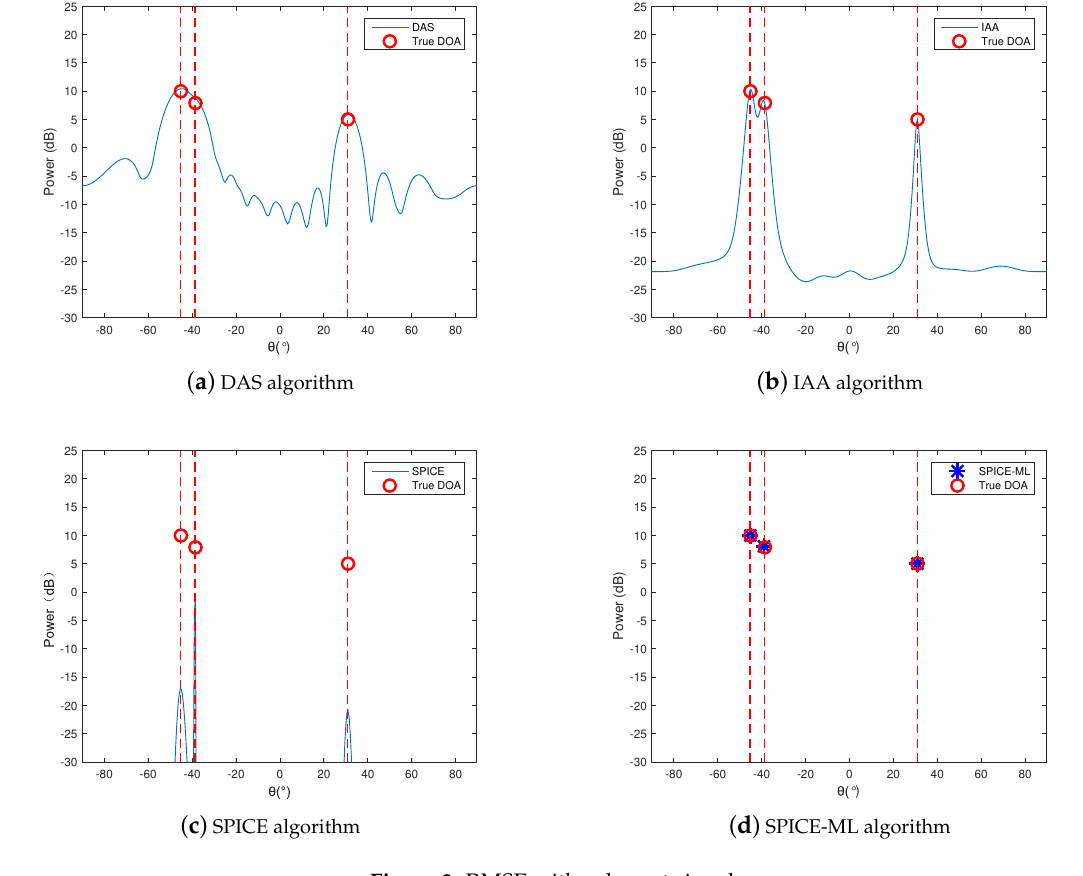
Figure 3. RMSE with coherent signal.